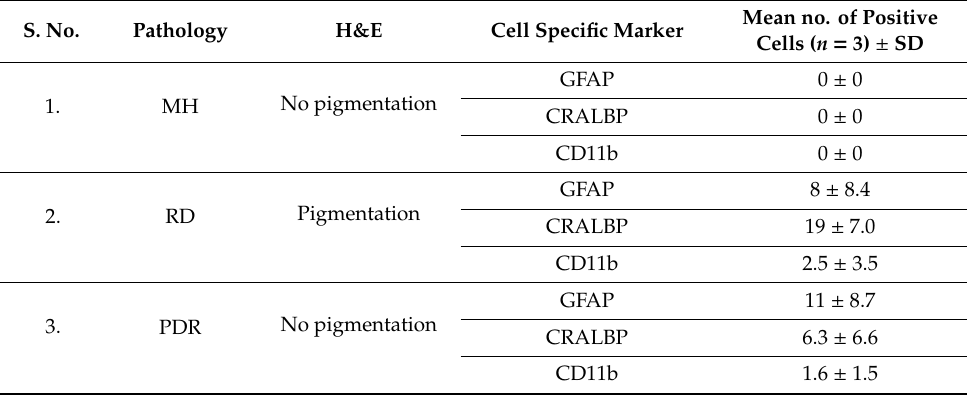
Table 1. The number of di ff erent cell types identified by immunohistochemistry using di ff erent specific markers where GFAP; astrocytes / gliotic changes, CRALBP; Müller glia, CD11b; microglia are used. S.